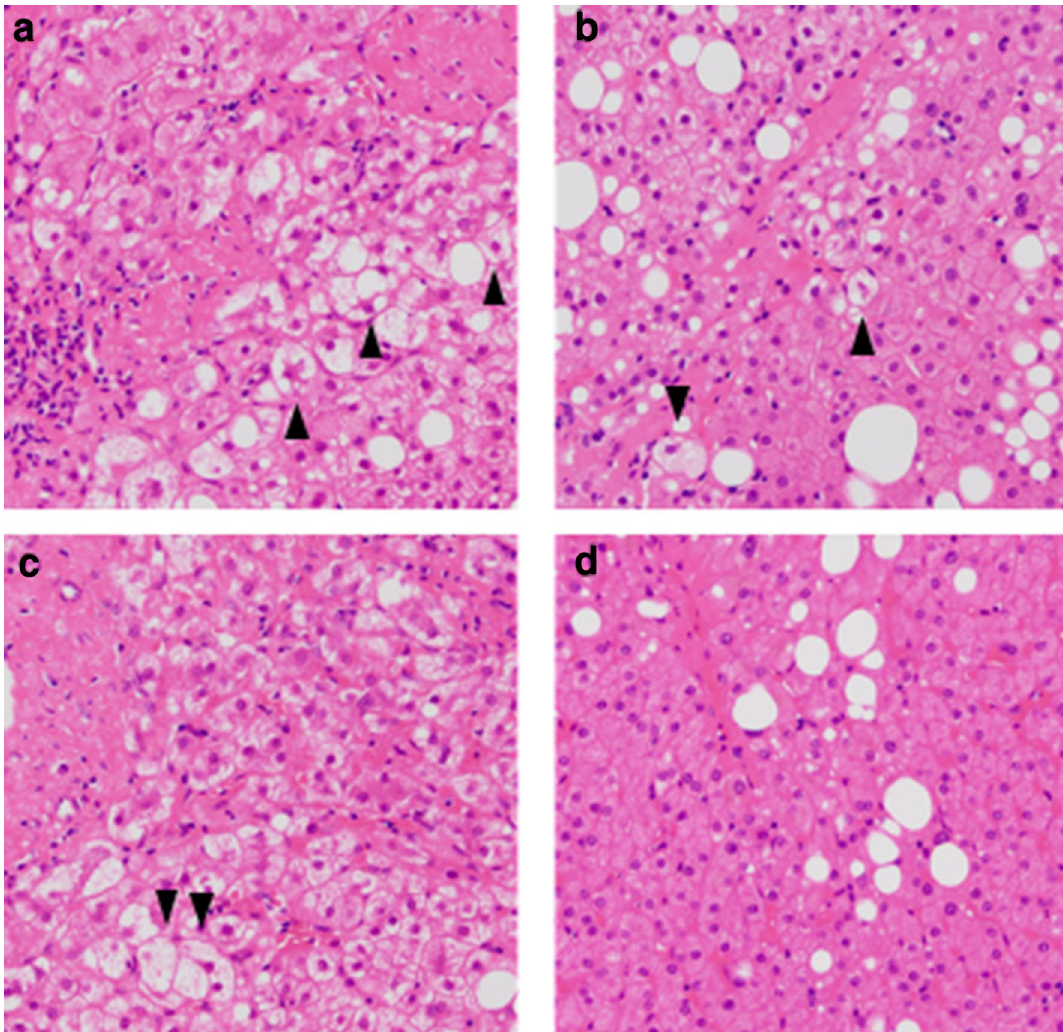
Figure 2. Histological images indicating hepatocyte ballooning. Histological images of liver biopsies using hematoxylin–eosin staining in one high-power field. Histological images of hepatocyte ballooning at the baseline in both the elimination ( a ) and persistent groups ( b ), and at indicated times in the persistent group ( c ) are presented; the arrowhead indicates hepatocyte ballooning. Liver histology at the indicated time in the elimination group is presented for comparison ( d